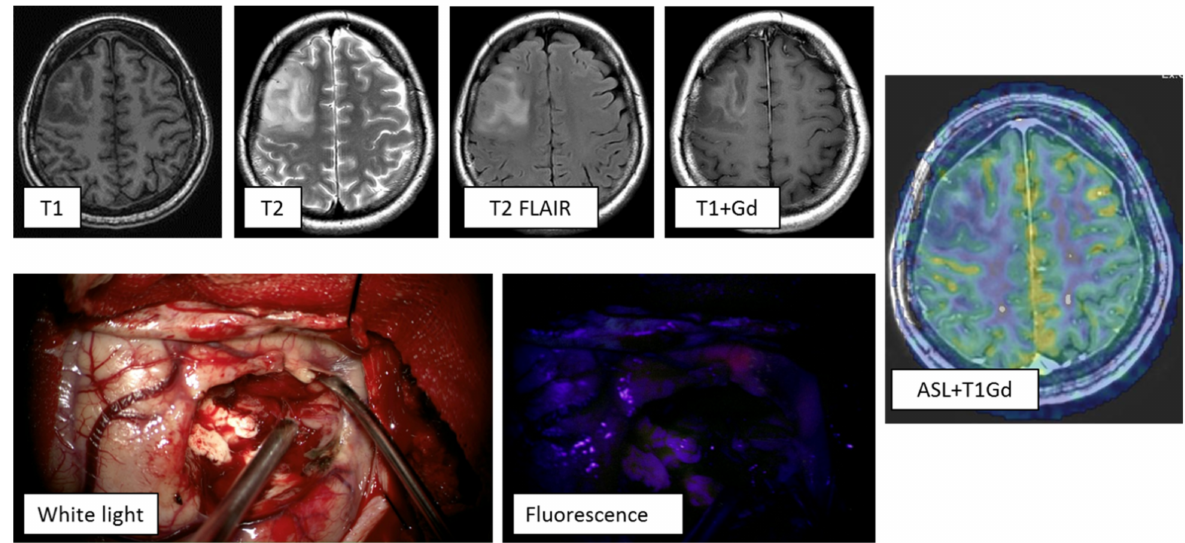
Figure 4. MRI study of a patient with a tumor of the right frontal lobe. ASL perfusion did not reveal areas of increased blood flow in the tumor stroma: TBF = 58.51 mL/100 g/min. During the operation, using fluorescence diagnostics, a dotted area of the fluorescence was visualized in the tumor, which was insufficient to determine its